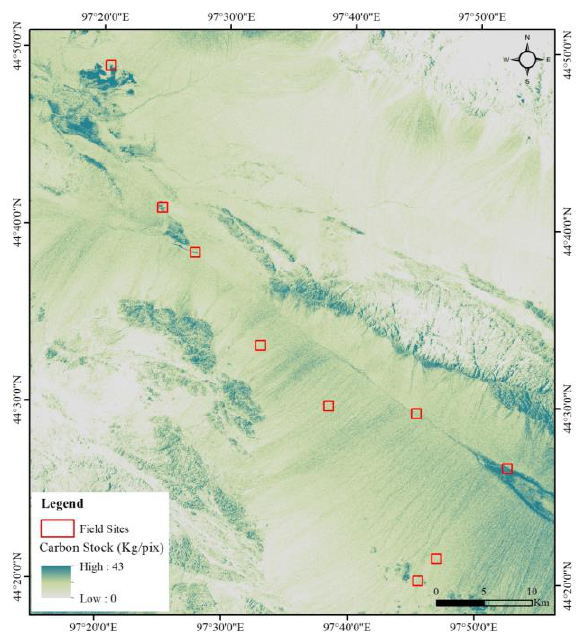
Figure 9. Shrubs carbon stock map in the western desert region of Mongolia. pix: Pixel area is 100m 2 . Average carbon stock is 5.1 kg/pix in this